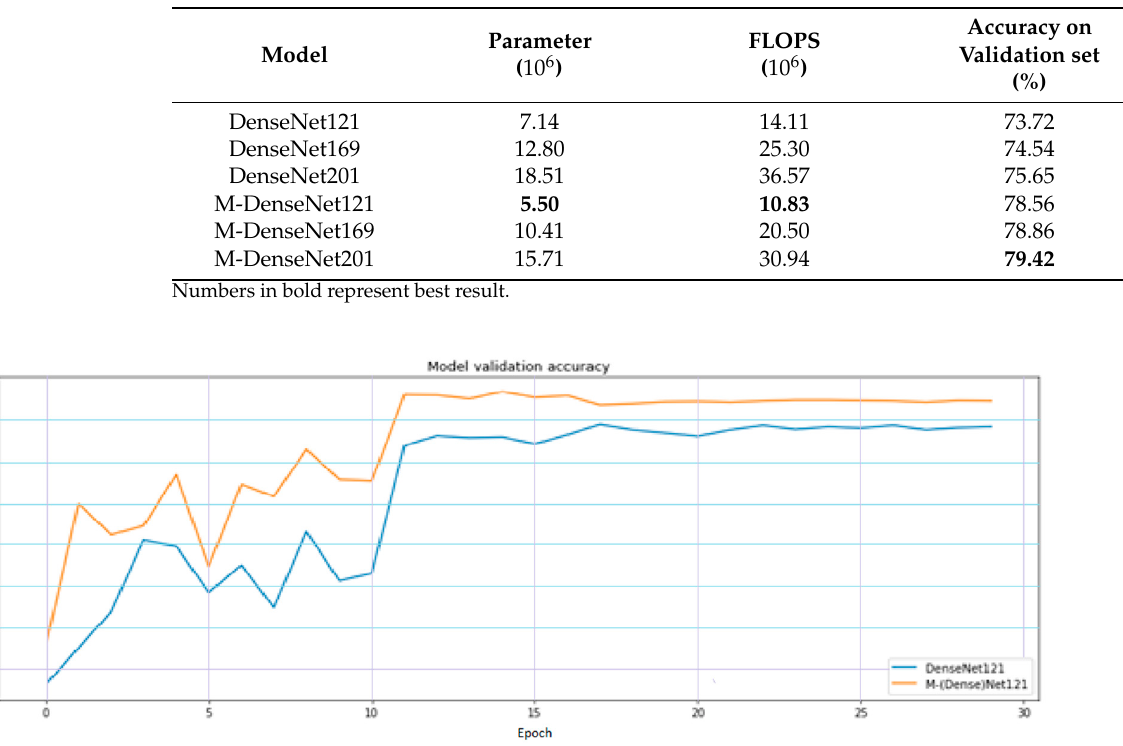
Table 3. Accuracy and FLOPs achieved by M-DenseNet in comparison with DenseNet.